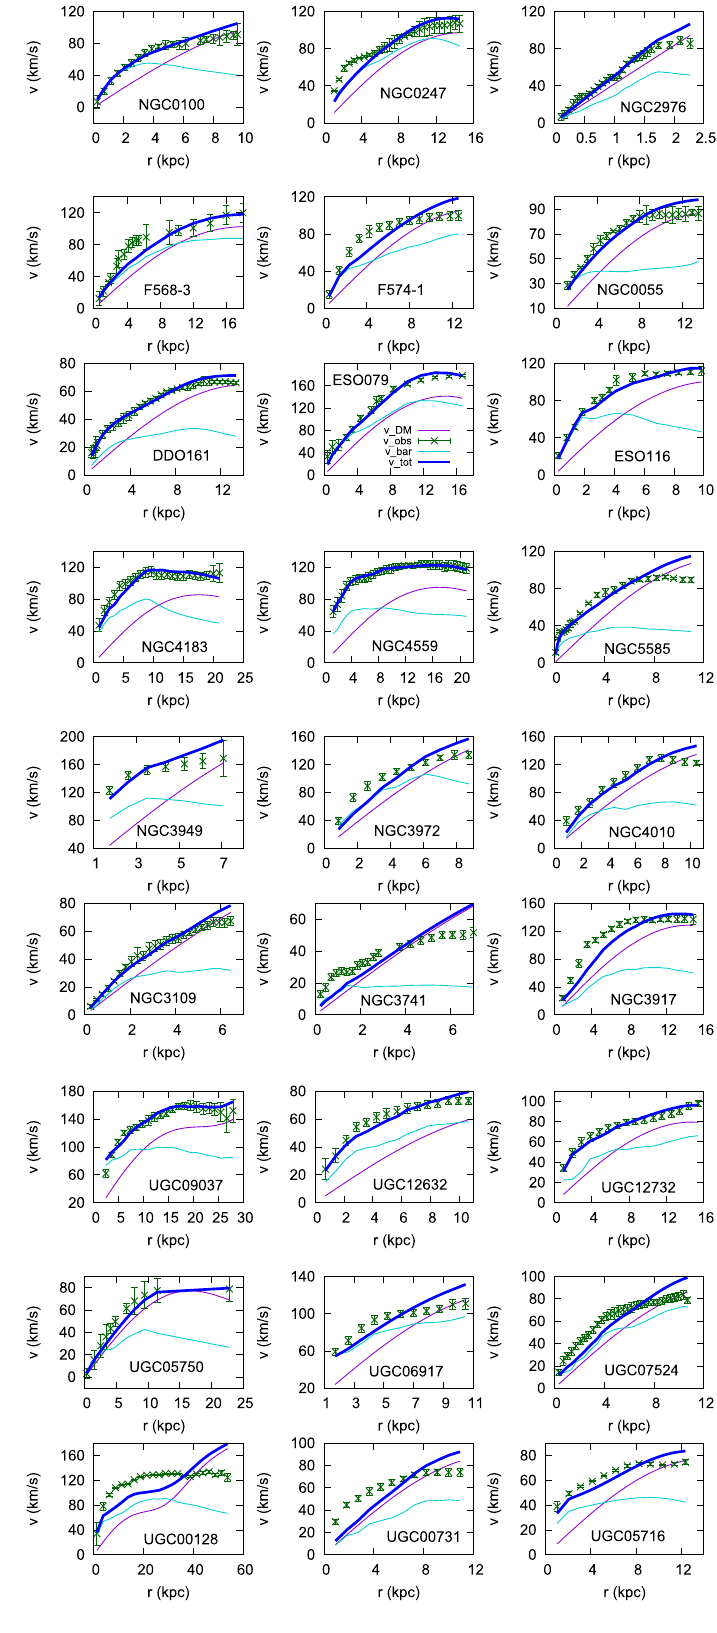
Fig. 9 Comparison of the theoretical predictions for the galactic rotation of the random Bose–Einstein Condensate dark matter model with 27 SPARC galaxies without bulge velocity for a universal static radius